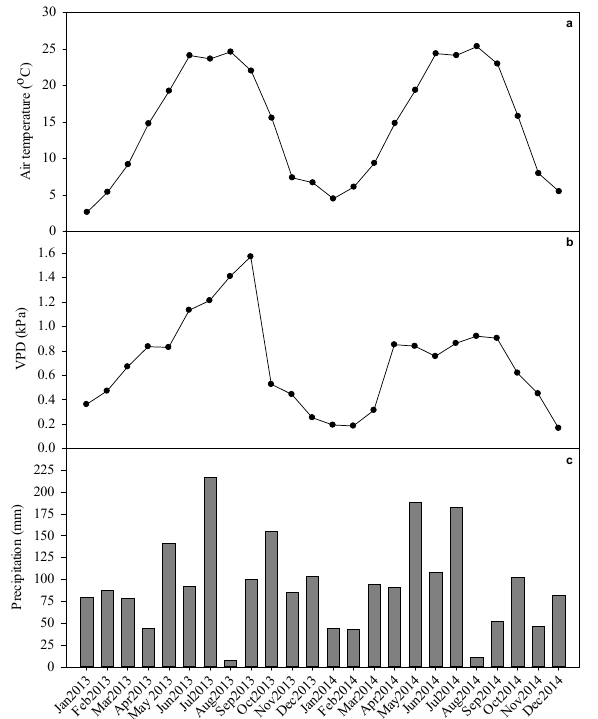
Figure 3. Mean monthly ( a ) air temperature; ( b ) mean monthly daytime vapor pressure deficit (VPD); and ( c ) total monthly precipitation for 2013 and 2014.